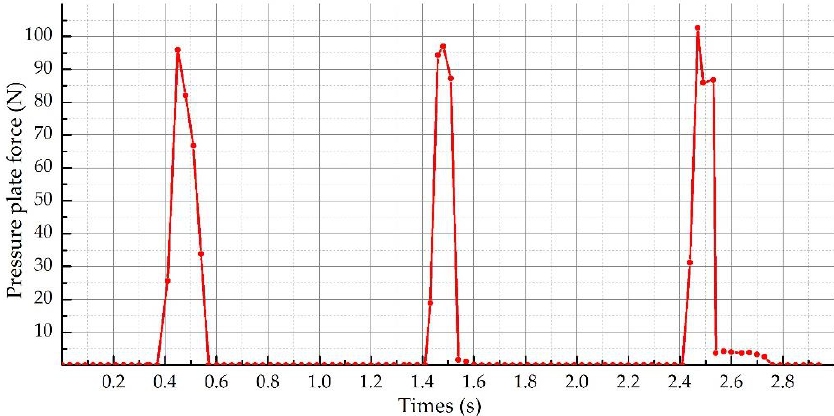
Figure 12. Simulation results of pressure plate force with RecurDyn.